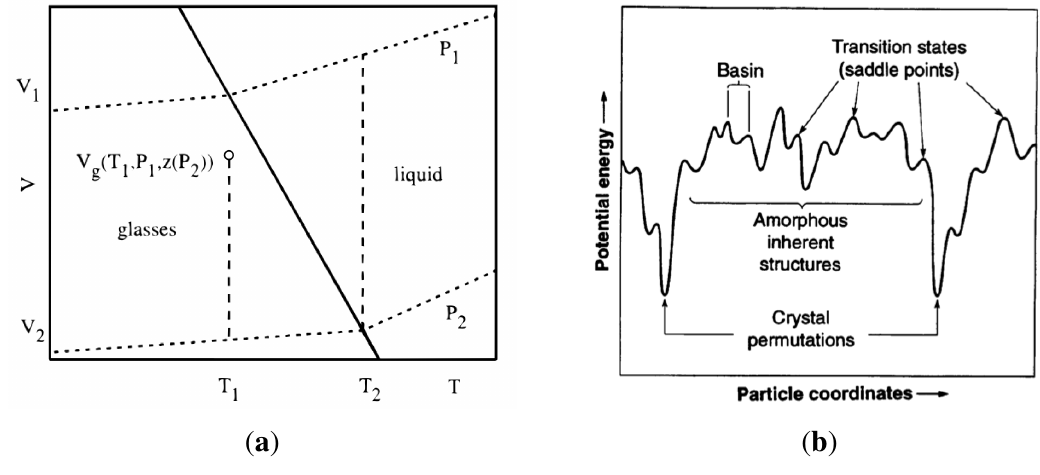
Figure 7. Volume-temperature phase diagram for a liquid-glass system. Reproduced from [81]. A schematic representation of the configurational phase space for glass. Reproduced from